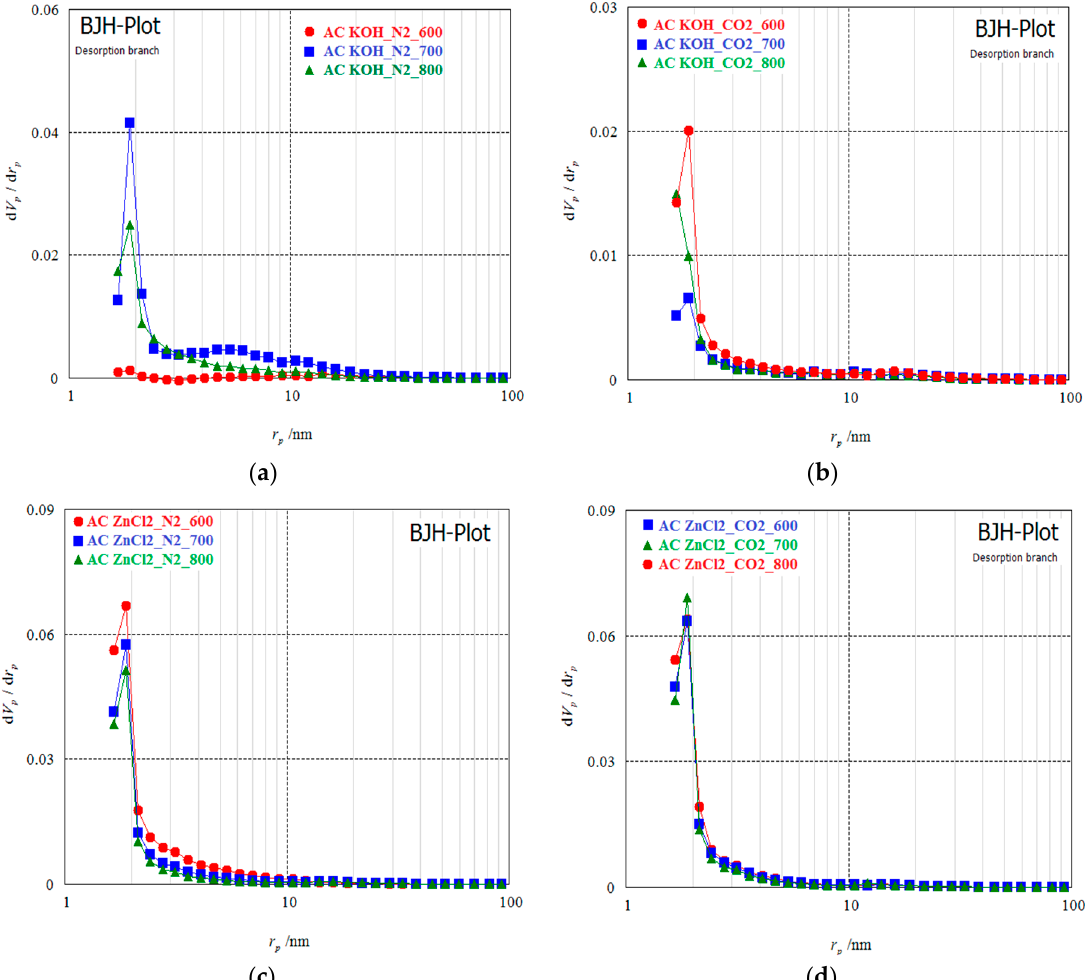
Figure 7. BJH analysis of AC prepared from pea pods impregnated using ( a ) KOH and carbonized under N 2 gas flow, ( b ) KOH and carbonized under CO 2 gas flow, ( c ) ZnCl 2 and carbonized under N 2 gas flow, and ( d ) ZnCl 2 and carbonized under CO 2 gas flow.